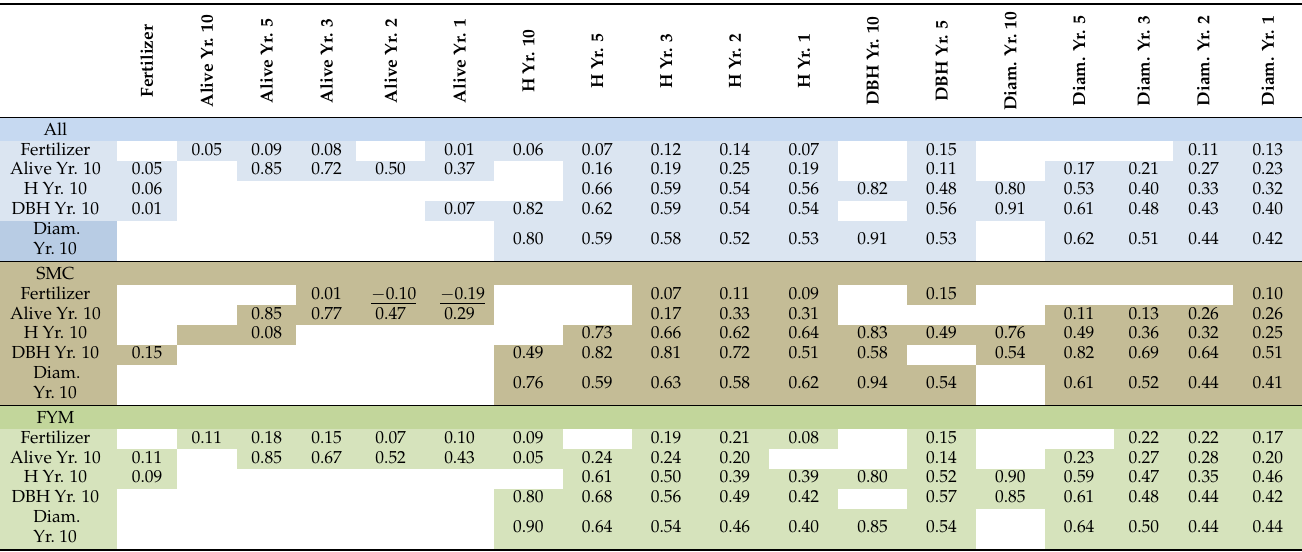
Table 4. Two-tailed significant ( p < 0.0005) correlations for the whole stand, SMC- stand and FYM-stand (H: cm; planted trees. Diam.: Basal diameter above the root collar mm, DBH